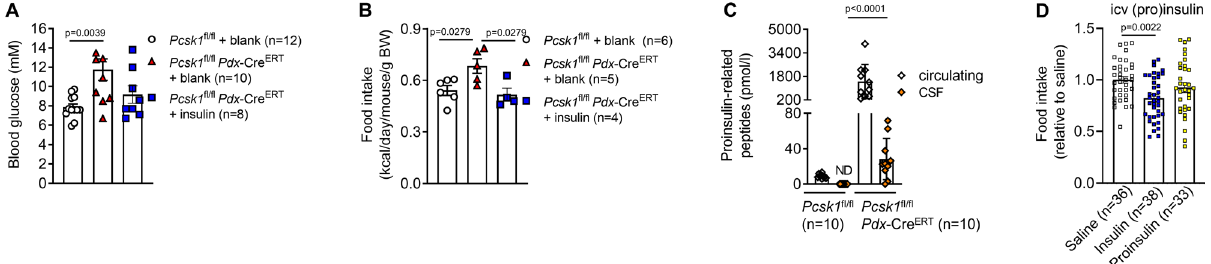
saline, 0.4 µ U insulin, or an equimolar amount of proinsulin. Open circles: Pcsk1 fl / fl , redtriangles: Pcsk1 fl / fl Pdx -Cre ERT ,bluesquares: Pcsk1 fl / fl Pdx -Cre ERT withinsulinpellet implants, open diamonds: circulating, orange diamonds: cerebrospinal fl uid, open squares:icvsaline,bluesquares:icvinsulin,yellowsquares:icvproinsulin.Dataare presented as mean values±SEM. A – D were analyzed by a one-way ANOVA with